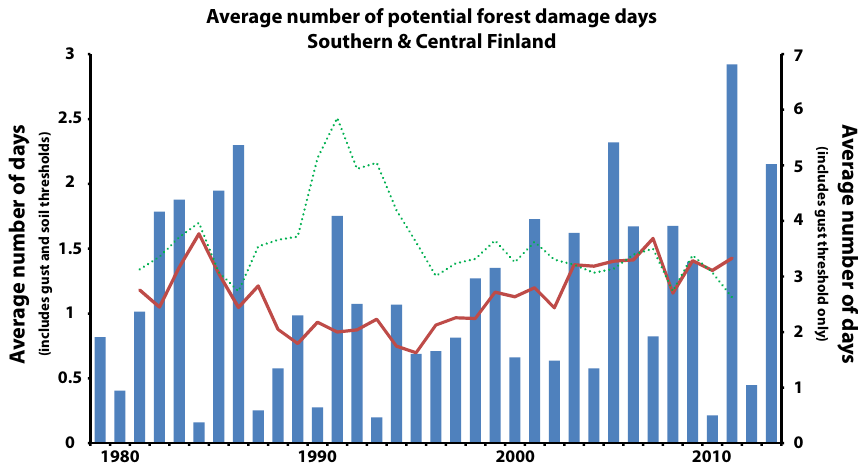
Figure 3. Potential forest damage days per year (days when the threshold levels are met or exceeded) in ERA-Interim during 1979–2013 (upper left panel) and decadal averages. The black box indicates the region over which the areal average in Fig. 4 is calculated.